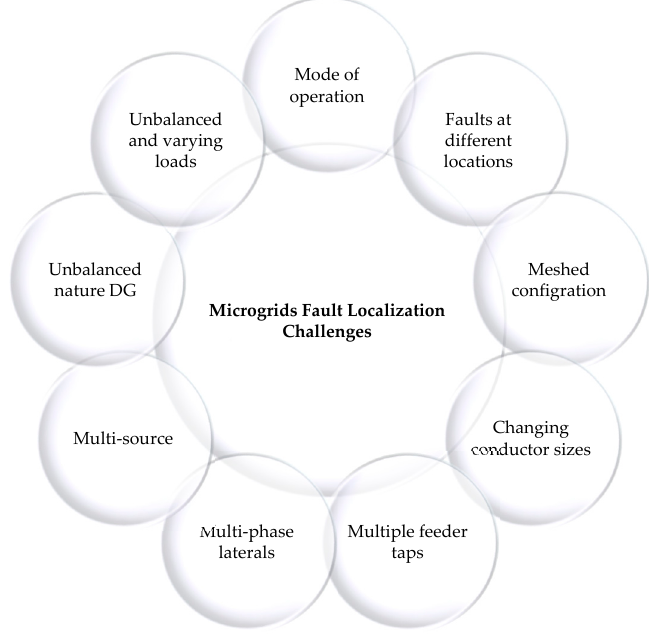
Figure 6. Fault location challenges of MGs.